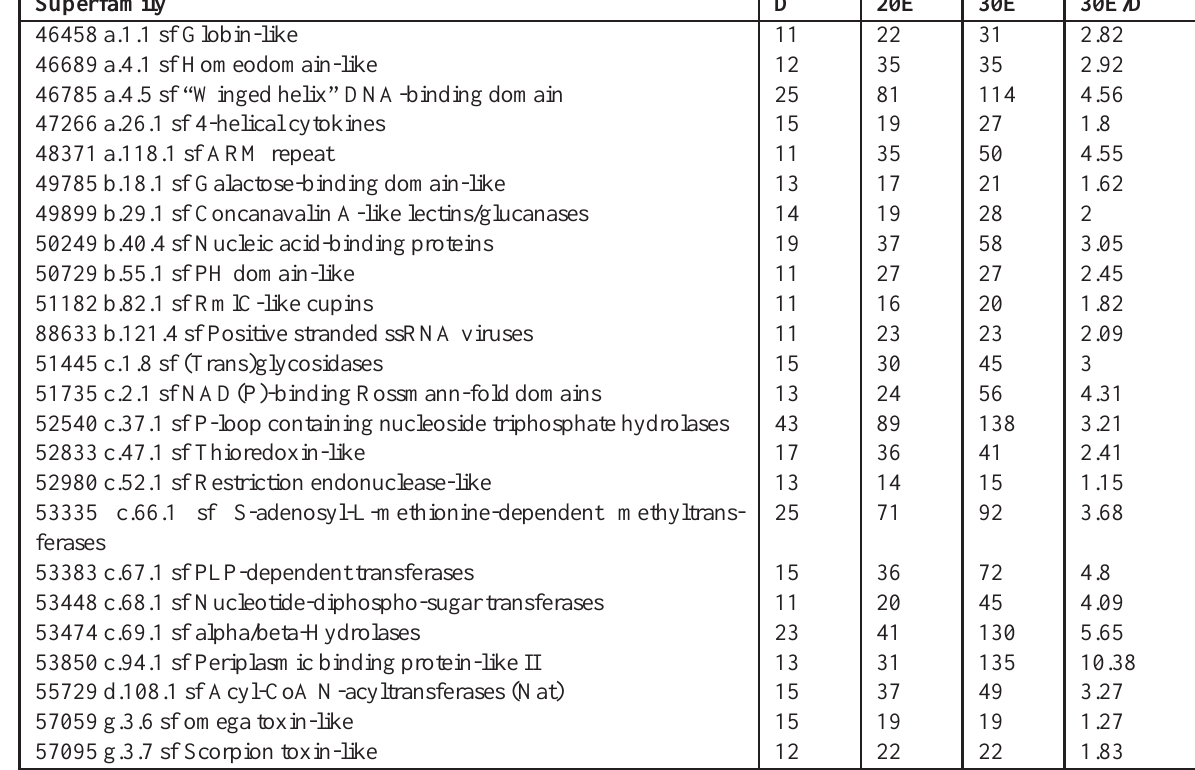
Table 2: Number of domains per superfamily (in the analysis that excluded multi domain proteins) from Astral20 before enrichment (D) and after enrichment at 20% (20E) and 30% (30E) sequence identity cutoffs